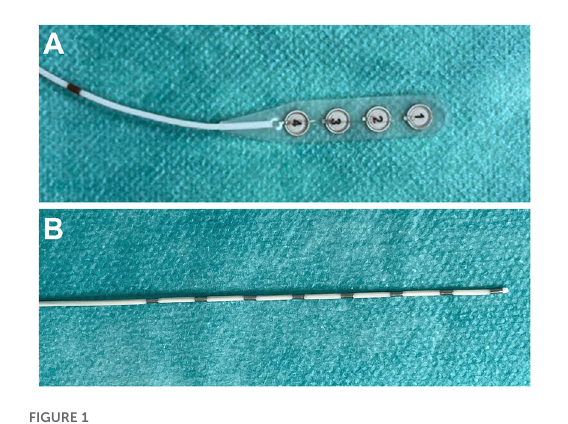
FIGURE1 Design of Wyler- and Spencer-type electrode arrays. (A) 4-contact Wyler-electrode. Electrode contacts are isolate on the backside of the electrode and have a diameter of 5mm. (B) 8-contact Spencer-type electrode arrays. Contacts are located at the darker part of the electrode with 10mm intercontact distance and 1.1 mm diameter. In contrast to the Wyler-electrode the Spencer-type electrode arrays have the same diameter across the whole length of the